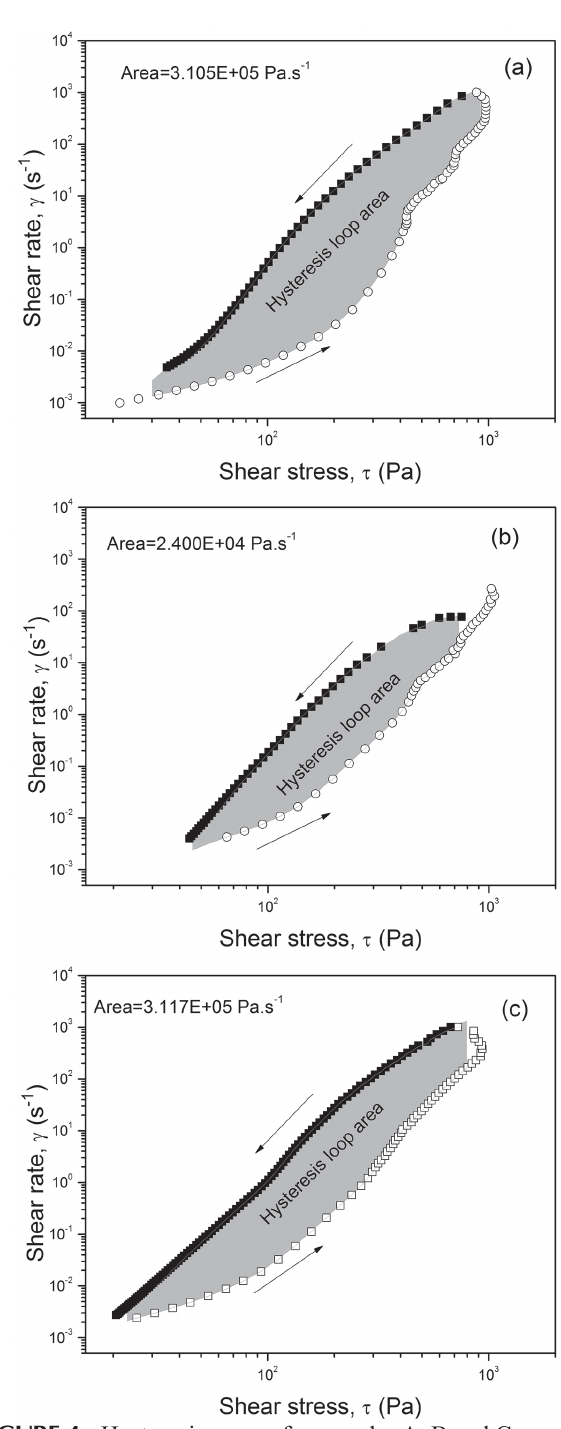
FIGURE 4 - Hysteresis curves for samples A, B and